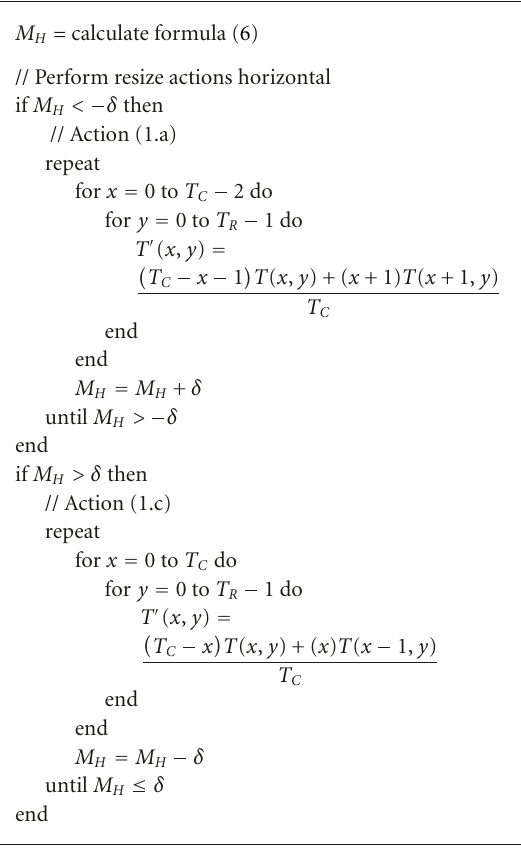
Algorithm 5: Perform resize actions horizontal.